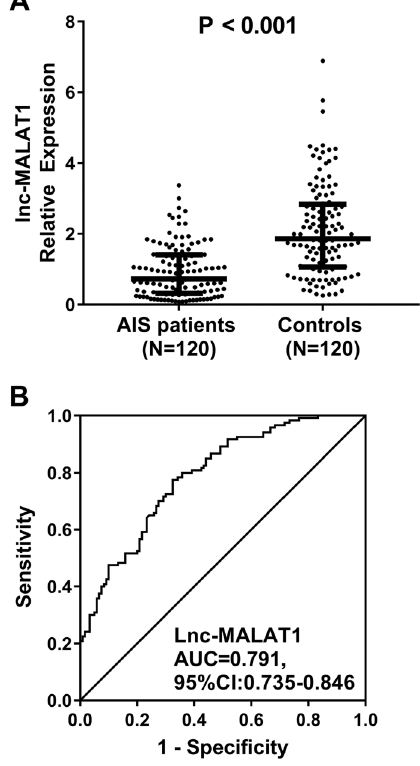
Figure 1. lnc-MALAT1 relative expression in acute ischemic stroke (AIS) patients and controls. Horizontal lines indicate means ± SD (Wilcoxon rank sum test) ( A ). Diagnostic value of lnc- MALAT1 for AIS was assessed by ROC curve ( B ). lnc-MALAT1: long non-coding RNA metastasis-associated lung adenocarci- noma transcript 1; ROC curve: receiver operating characteristic curve; AUC: area under the curve.